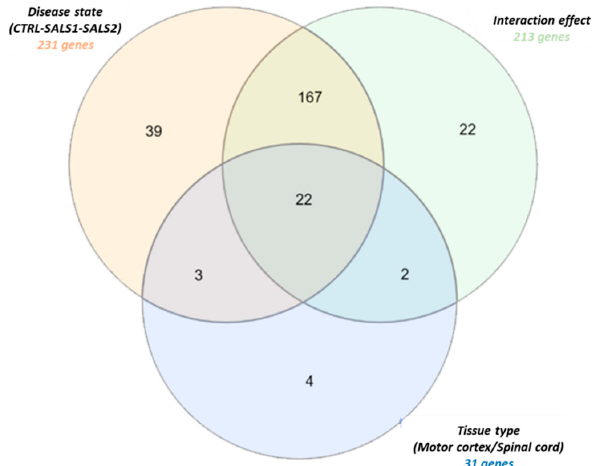
Figure 2. Venn diagram of di ff erentially expressed splicing factor genes in tissue districts (motor cortex and spinal cord) of control and SALS subtype patients. Detailed information for the lists of gene probes is provided in Supplementary Data